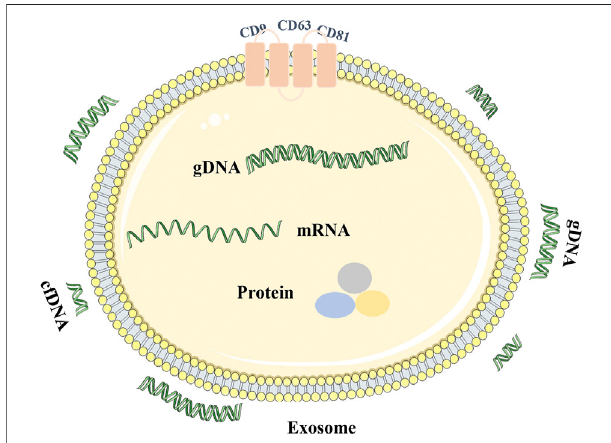
FIGURE 1 | Characterization of exosome gDNA. The short double- strandedDNAiscfDNAandthelongdouble-strandedDNAisgDNA.DNAcan be enclosed within exosome, attached to the outer surface of exosome or enclosed and attached to the outer surface of exosome.